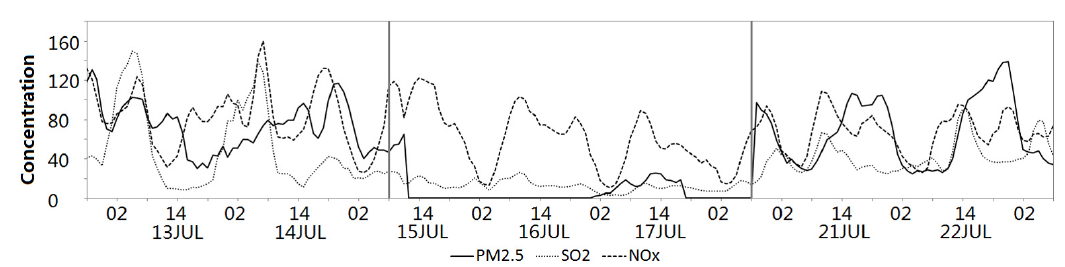
Fig. 7. Measured air pollutant concentrations at Guangzhou station on 13–22 July 2006 (units: PM 2 . 5 , mgm − 3 ; SO 2 , ppb; NO x ,